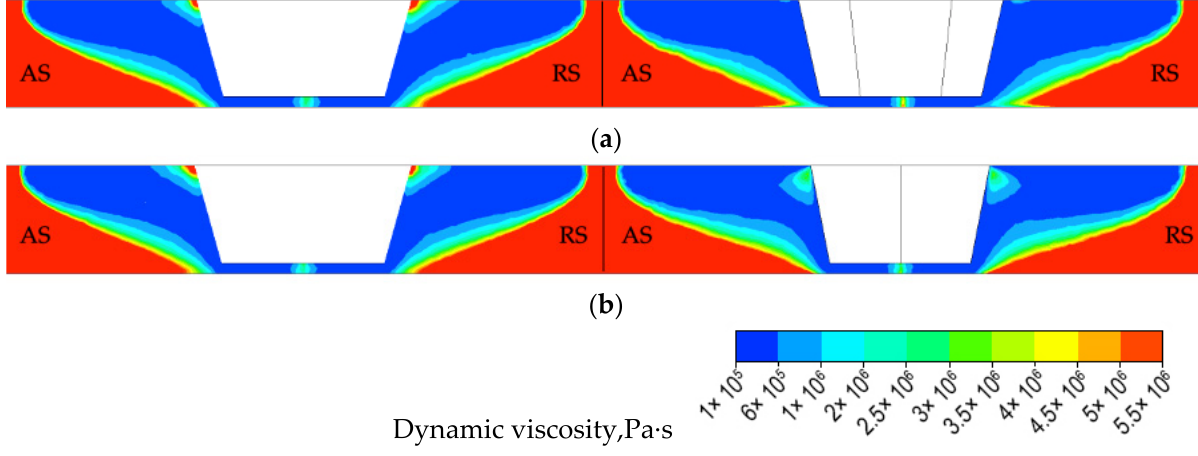
Figure 10. The distribution of the dynamic viscosity for both FSW − C ( left ) and FSW − H ( right ) samples, ( a ) transverse and ( b ) longitudinal section.